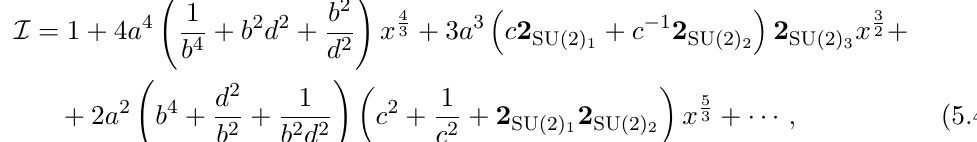
Figure 15 . The 3 d quiver representation of the torus with flux (2 choice for the parametrization of the abelian symmetries and the